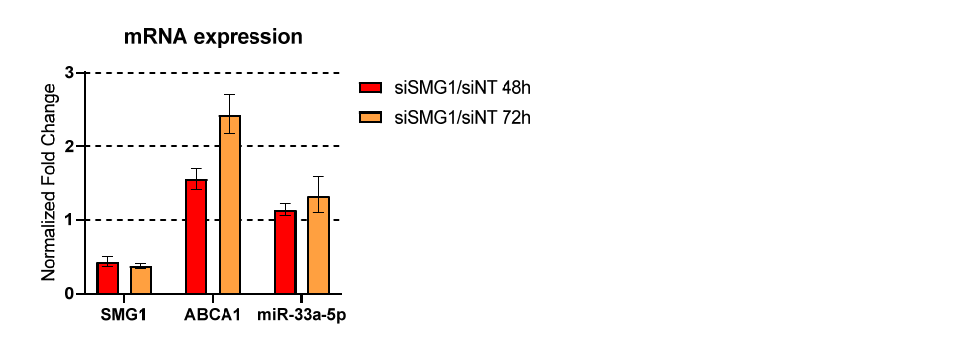
Figure A4. Western blotting verification of RASSF1 antibody and overexpressed isoforms. H1299 cells were transfected with HA-tagged RASSF1A (Addgene#1980), HA-tagged RASSF1C (Addgene#1981), FLAG-tagged RASSF1C (Addgene#1977) or empty vector and harvested 2 days post-transfection. HA or FLAG tags were probed by Anti-HA: Anti Flag mixed antibodies. RASSF1A and C were probed by RASSF1 antibody (EPR7127, Abcam). Vinculin was probed as load- ing control.